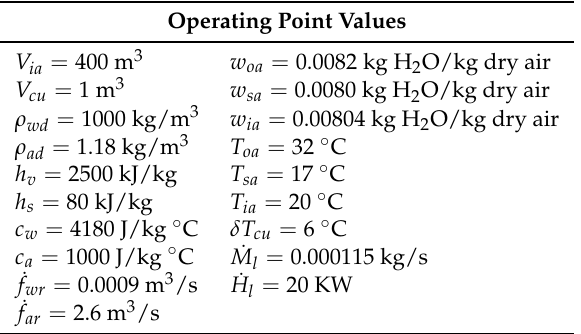
Table 2. Thermo-fluid parameters values in air handling unit around an operating